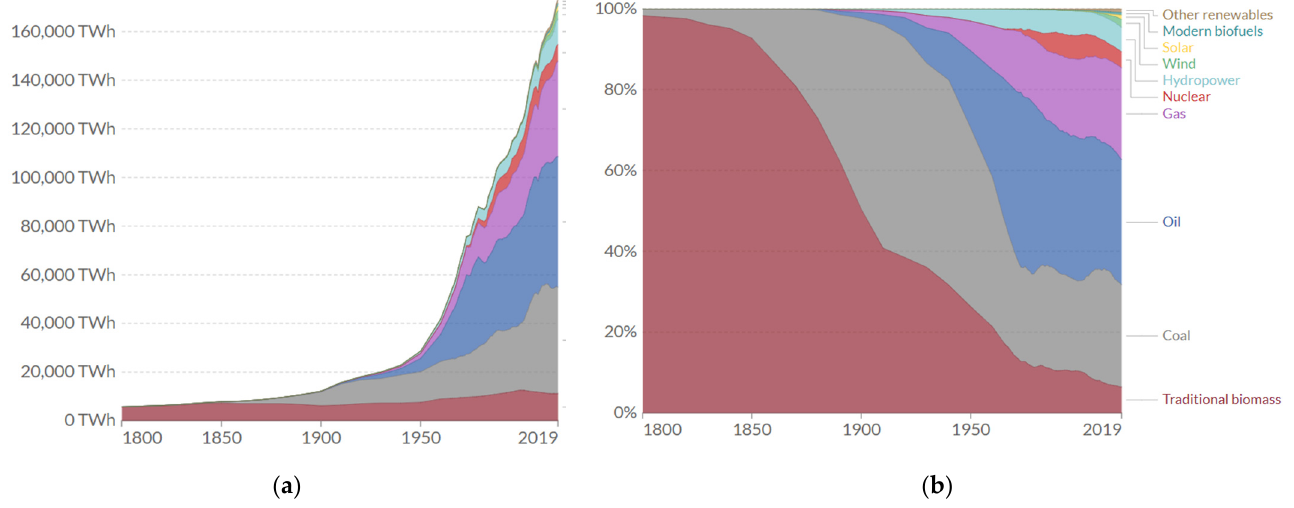
Figure 1. Global primary energy consumption by source: ( a ) In Twh; ( b ) relative (%) [17].